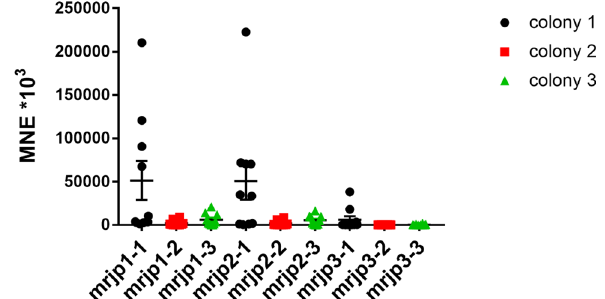
Figure 3. Abundance of transcripts of mrjp1 , mrjp2 and mrjp3 in the brain of control foragers (n = 10) of colony 1 (black symbols), colony 2 (red symbols) and colony 3 (green symbols). No significant differences were found for the expression of the three examined transcripts between the three different colonies.